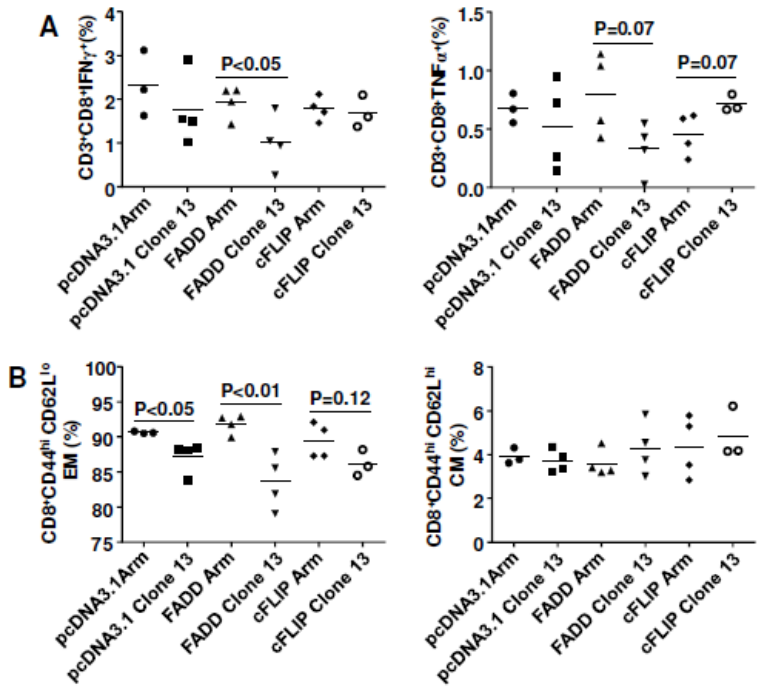
Figure 7. cFLIP maintained cellular immune responses in chronic lymphocytic choriomeningitis virus (LCMV) infection. Mice were electroporated with 2 µg plasmids of pcDNA.3.1, FADD or cFLIP on day zero (d0). On day 7, mice were infected with either 2 x 10 5 plaque-forming-units (PFU) LCMV-Armstrong i.p. or 2 x 10 6 PFU LCMV-Clone13 i.v.. Nine days later, mice were sacrificed and assessed for cell-mediated immunity. ( A ) Intracellular cytokine staining; ( B ) Memory cell responses.